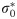
The ABM that describes evolution of division rate variability induces clone loss and clonal dominance.A–B Clone loss (A) and Gini coefficient (B) for a range of initial division rate SDs (σ0*) and mutation SDs (σm*), with all other parameters as in Table 1 and all data points representing the mean for 10 simulations.